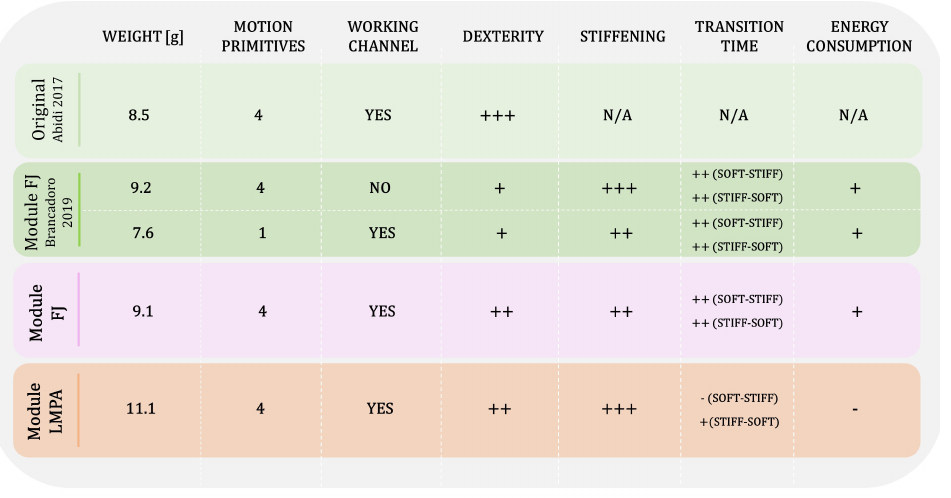
Figure 10. Module features: for each module, the weight, the presence of the inner free lumen (i.e., a working channel), the number of MPs, the performance in terms of stiffening and dexterity, the transition time, and the energy consumption are reported and compared to